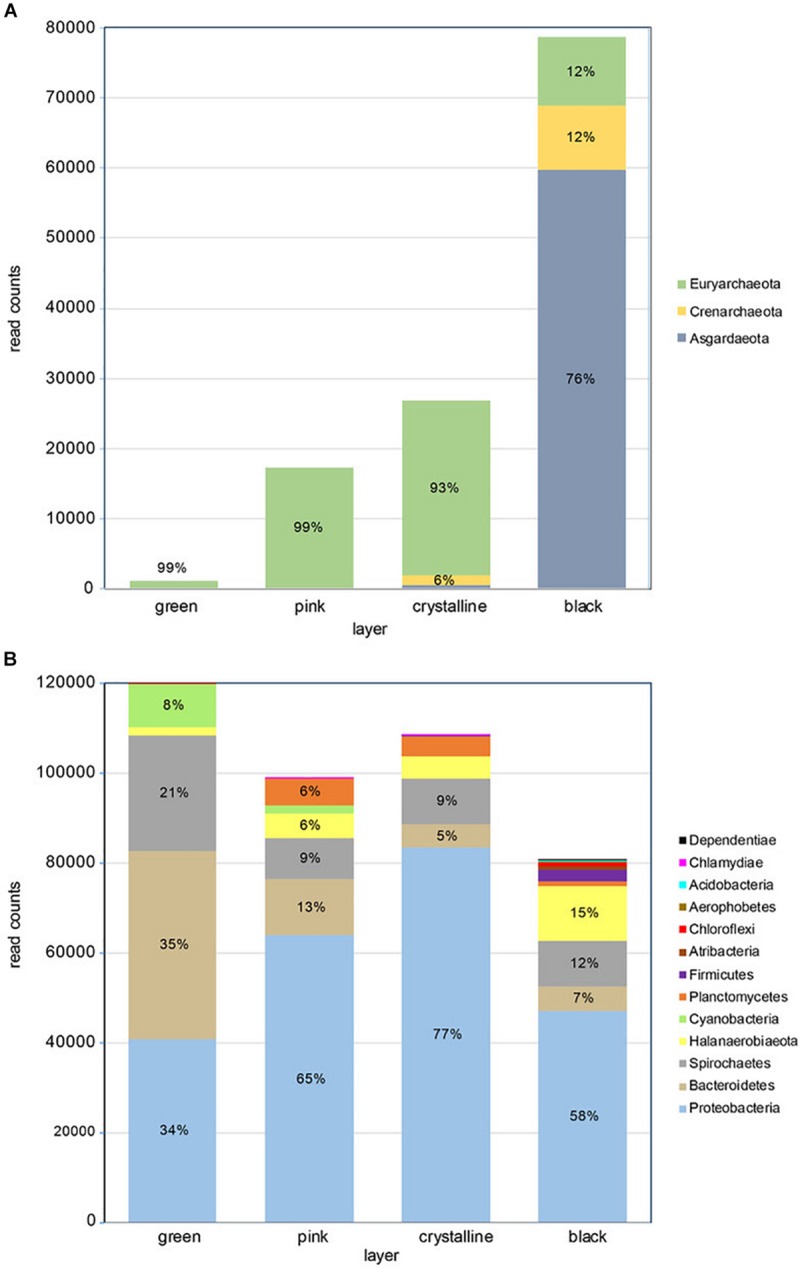
Taxonomic composition of microbial mat layers showing (A) archaeal read counts and (B) bacterial read counts. The relative phyla frequency within a layer is indicated in percent if respective read counts constitute >5%.